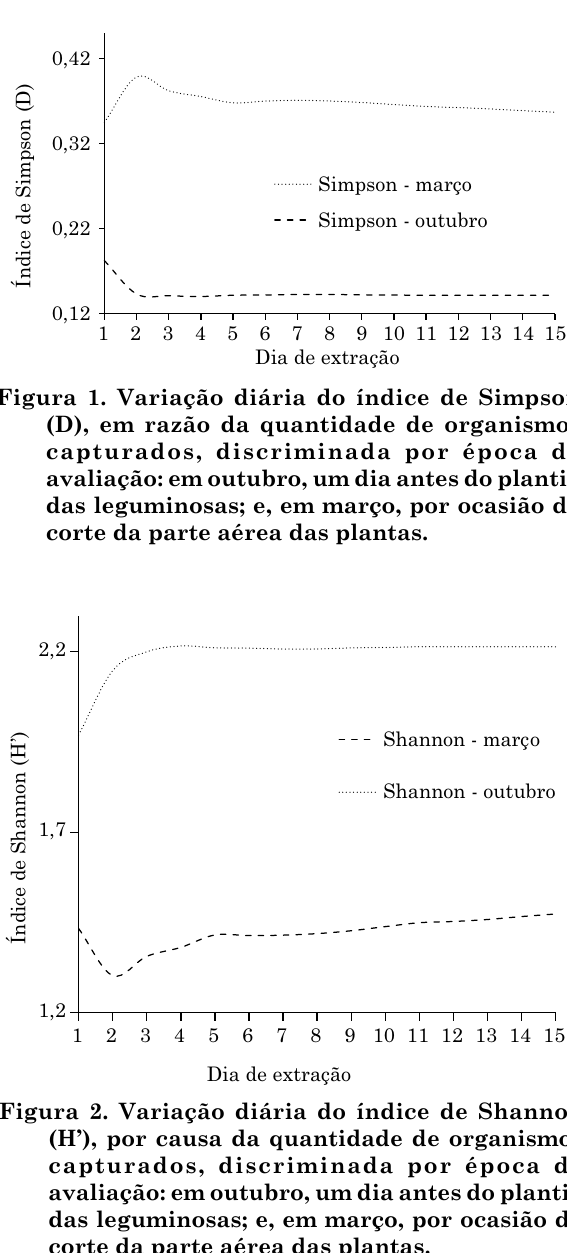
Simpson - outubro